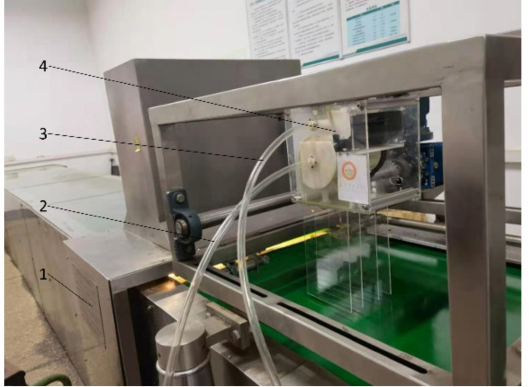
Figure 6. Indoor seeding test. 1. JPS-12 seeding performance test bed; 2. Seed unloading duct; 3. Seed cleaning duct; 4. Seed